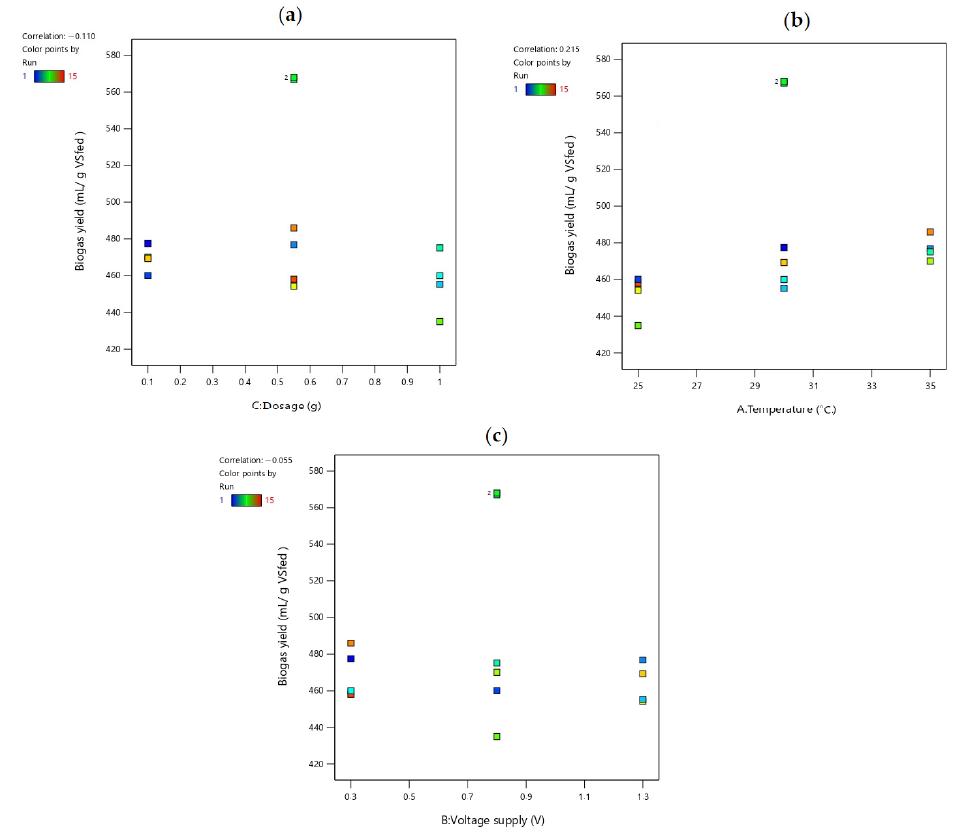
Figure 1. Effect of ( a ) magnetite nanoparticle dosage; ( b ) temperature; and ( c ) voltage supply on biogas yield.